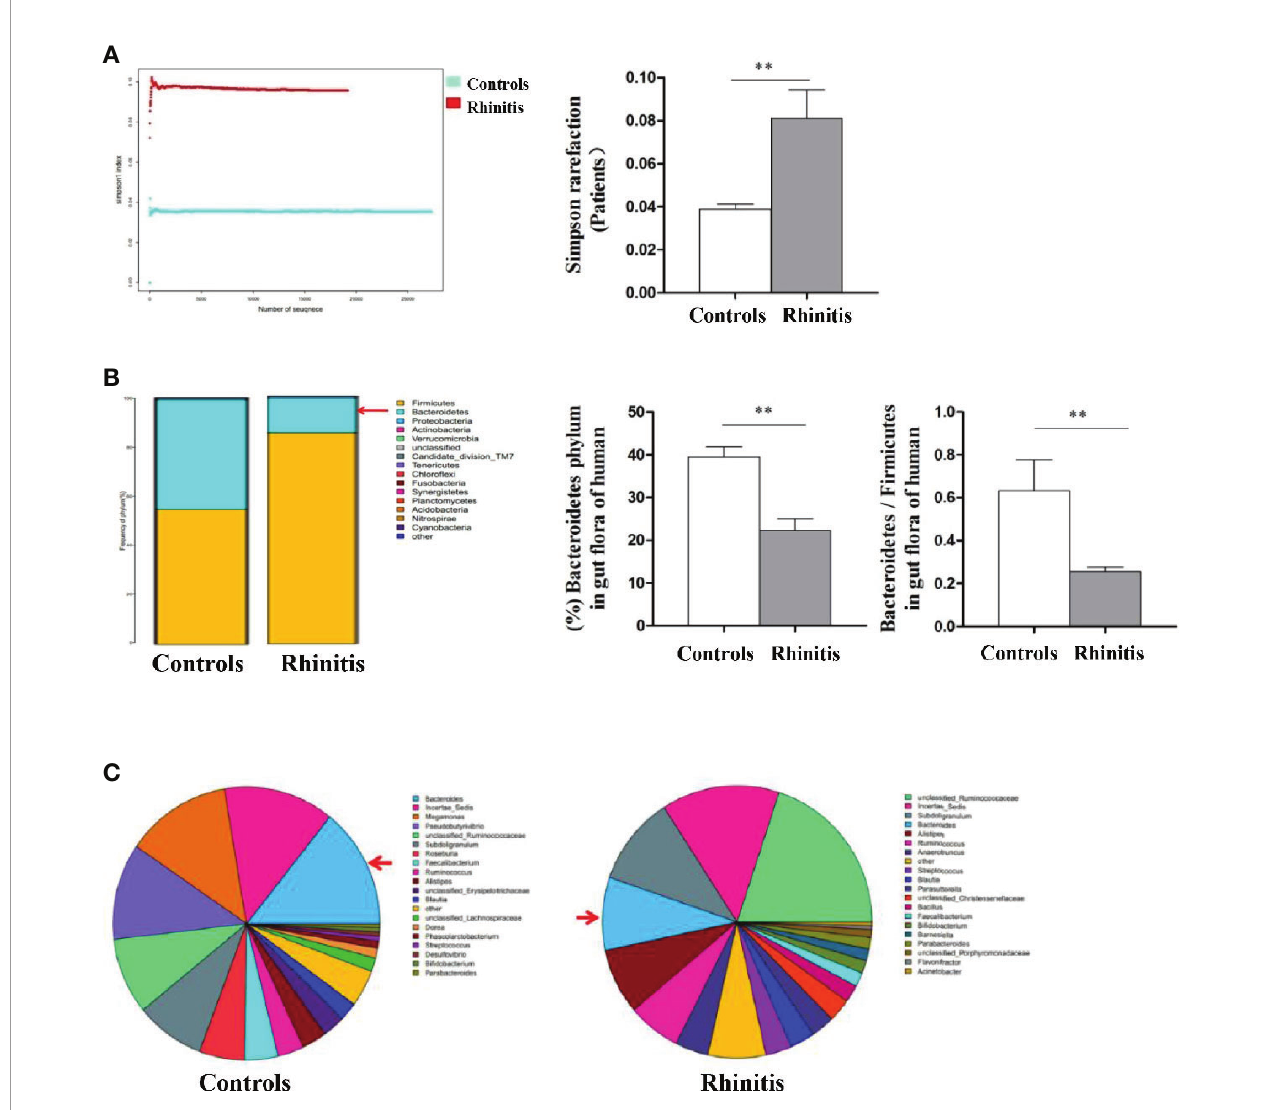
FIGURE 2 | The diversity and abundance of intestinal micro fl ora in patients with allergic rhinitis. (A) The Simpson rarefaction in allergic rhinitis patients increased compared with that in healthy controls. (B) Bacterial composition and abundance at the phylum level. Red arrow: Bacteroidetes. (C) Bacterial composition and abundance at the genus level. Red arrow: Bacteroides. Bar graphs represent mean ± SD (n = 6). ** P <